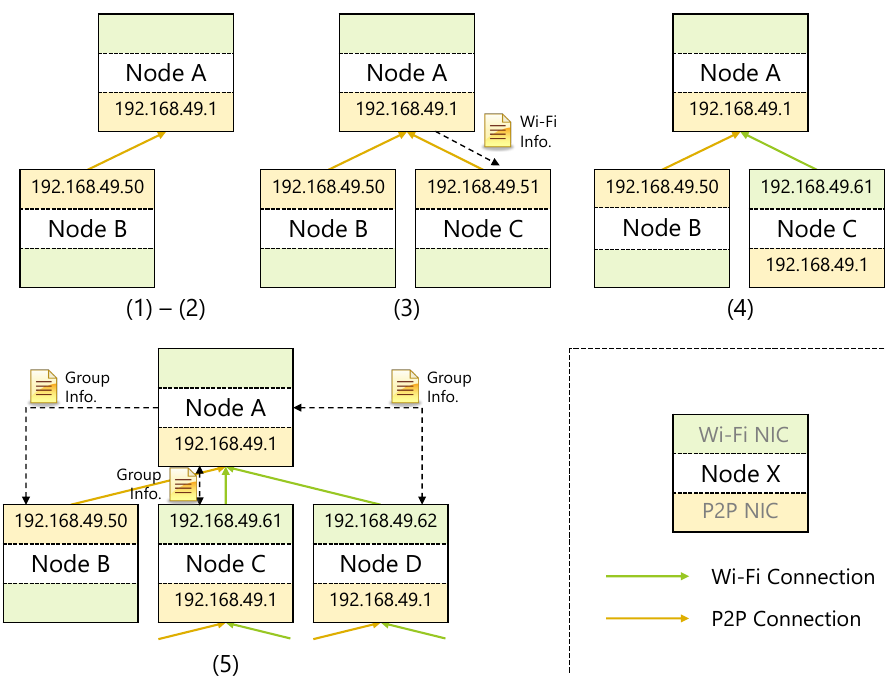
Figure 2. Steps for topology construction. Each number corresponds to the processing procedure in the text.